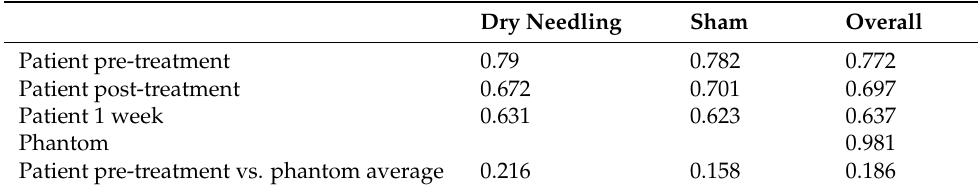
Table 2. Intraclass correlation coefficient values.